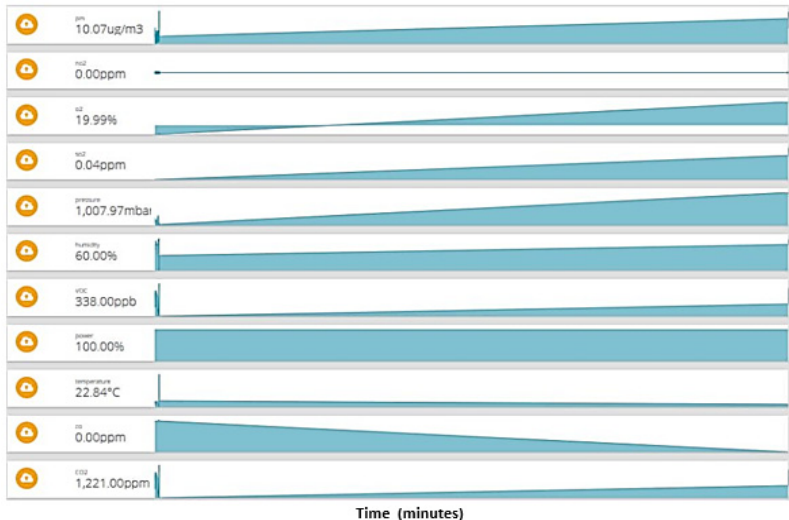
Figure 5. The SeReNo2 IoT Dashboard at Ubidots IoT. The eleven real-time variables were exhibited in Figure 4, sending data through the GSM model QuecTel M10. The bi-cluster is considered in this special data-fusion case for